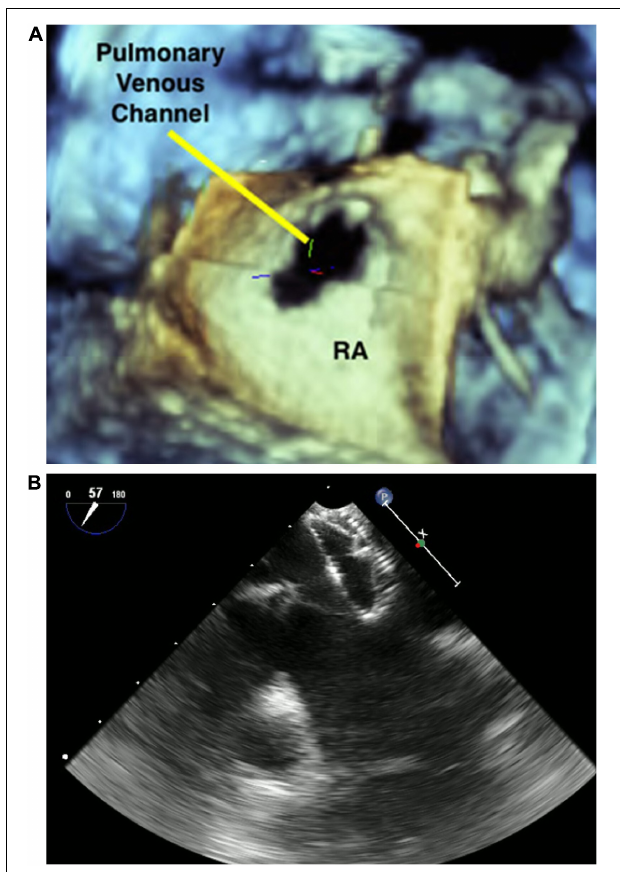
FIGURE 3 | 3D image of pulmonary venous channel in a patient who underwent atrial switch (A) . Baffle leak closure (B)